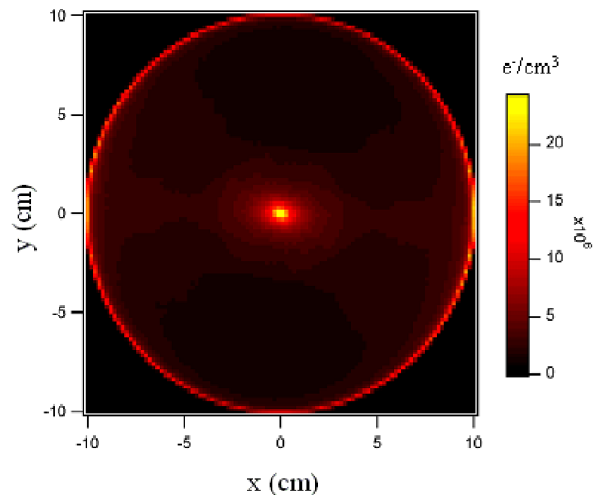
FIG. 13. (Color) Image of the time-averaged density of the electron cloud in an SNS field-free region. The higher-density horizontal ‘‘stripe’’ is due to a statistical fluctuation caused by strong multipacting.